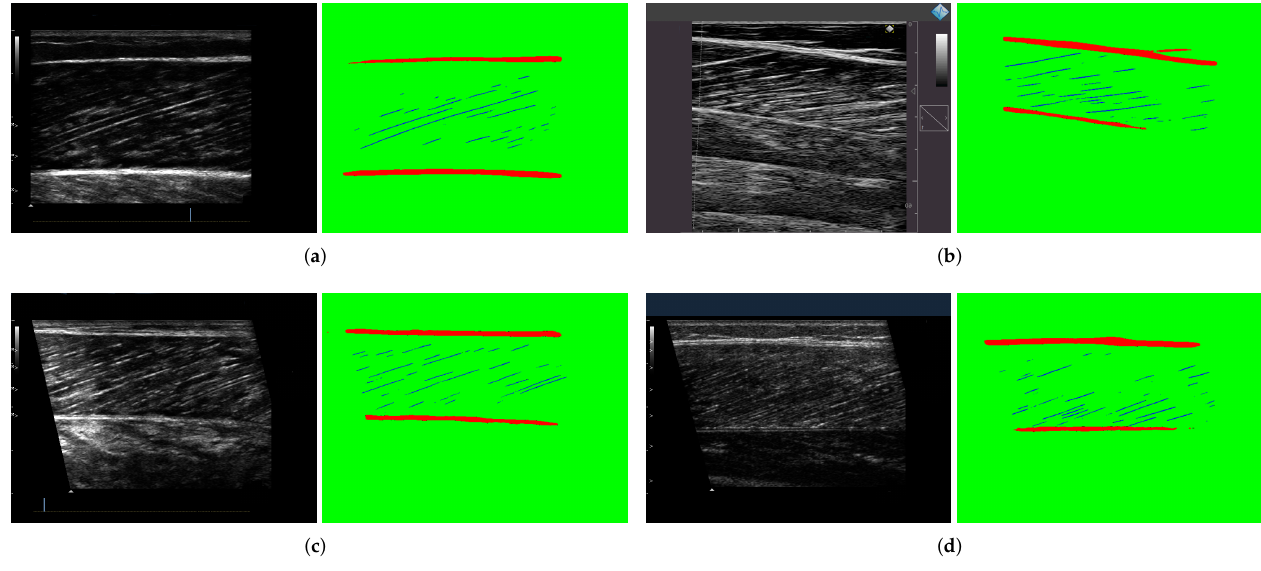
Figure 6. The segmentation results of 4 groups of ultrasonic images with different noises. The left side of each group is the original image, and the segmentation result is on the right. ( a ) The noise in original image is low, but some fascicles are not clear. ( b ) The noise in some areas of the original image is high. ( c ) The fascicles in the original image are clear, and the noise is low. ( d ) The noise of original image is obvious and fascicles are very